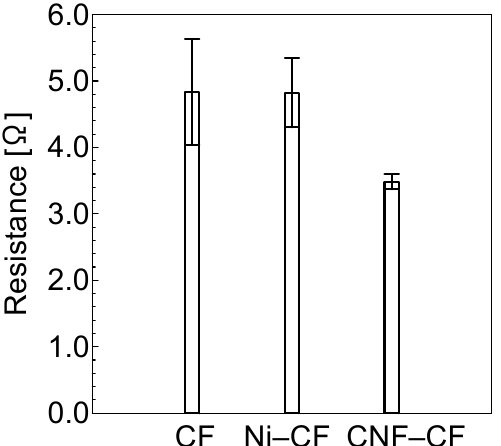
Figure 6. Electric resistance of each carbon fiber. (N = 6, mean ± S. D.).